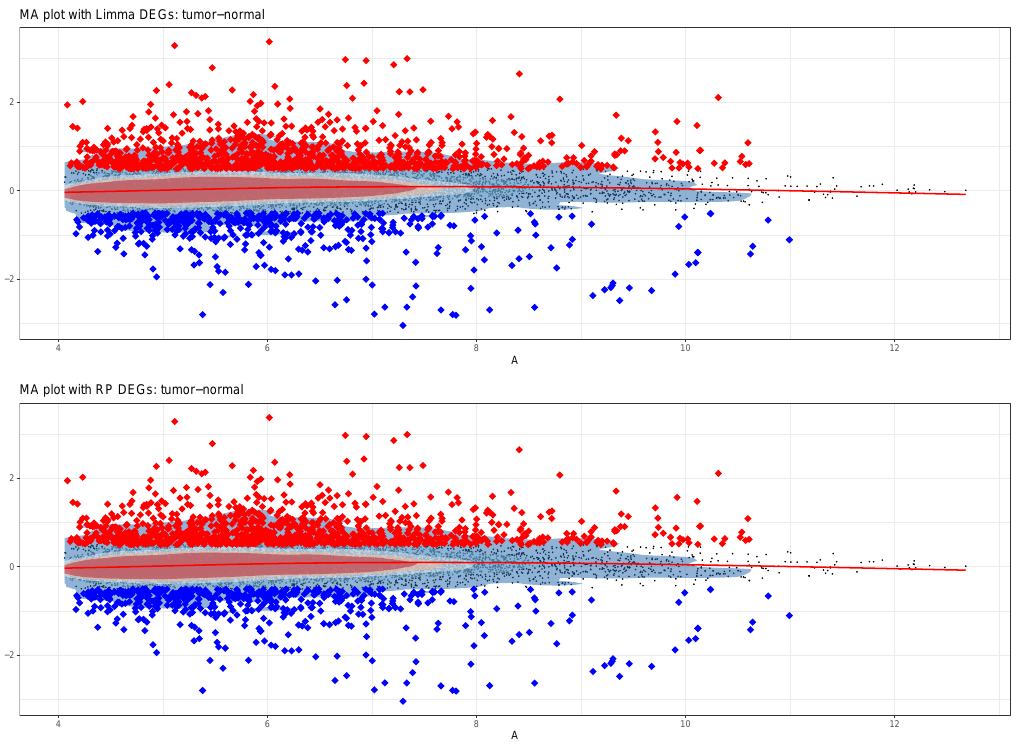
Figure 4. Bland–Altman plots showing the detected DEGs as either upregulated (red) or downregu- lated (blue), as detected by limma (top) or RankProduct (bottom) in the Zhang data set. The two plots look identical, a sign that DEG detection was